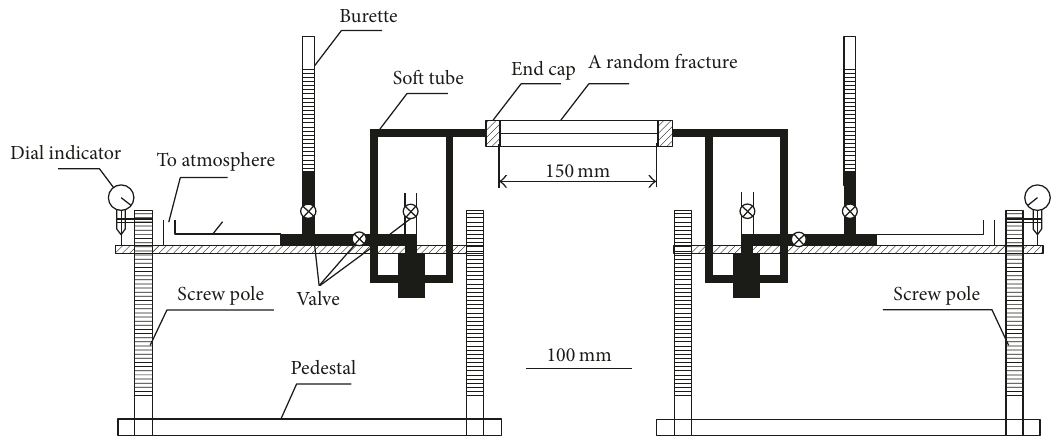
Figure 4: Sketch of the experimental setup.